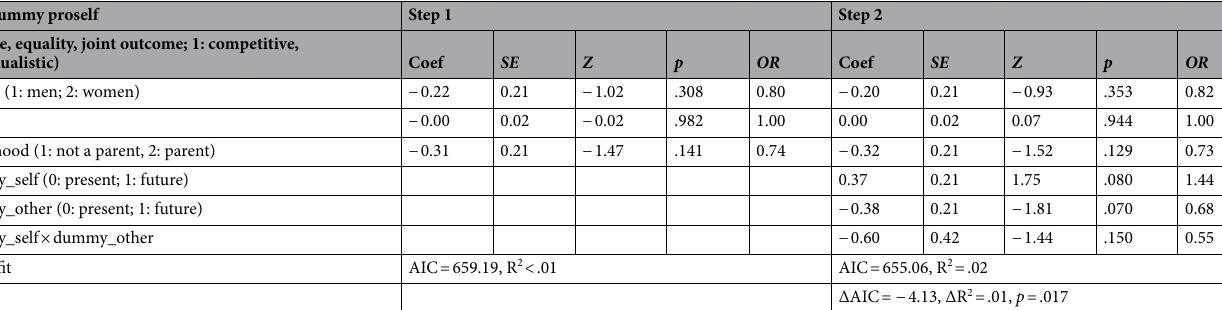
Table 2. Results of logistic regressions for the proself dummy variable. R 2 indicates Cox and Snell R 2 values. Coef. = coefficient; SE = standard error; OR = odds ratio; AIC = Akaike’s information criteria.